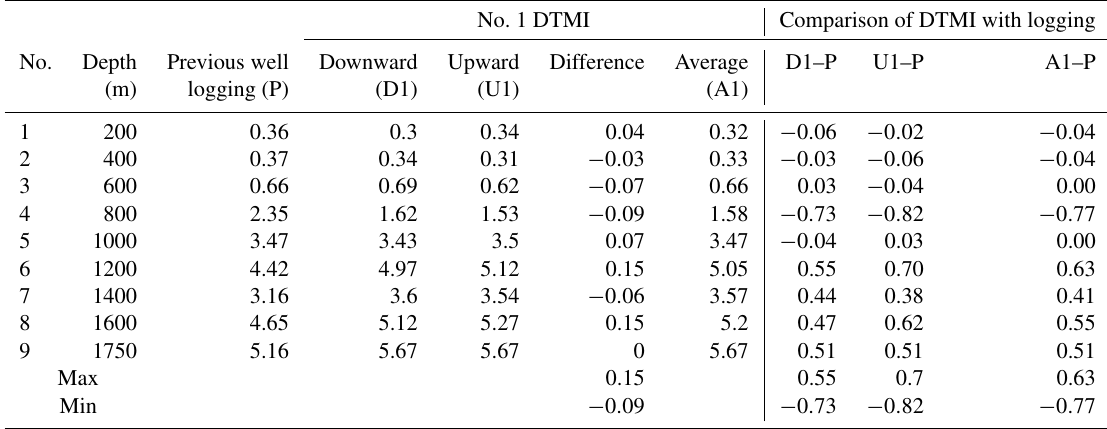
No. 1 DTMI Comparison of DTMI with logging